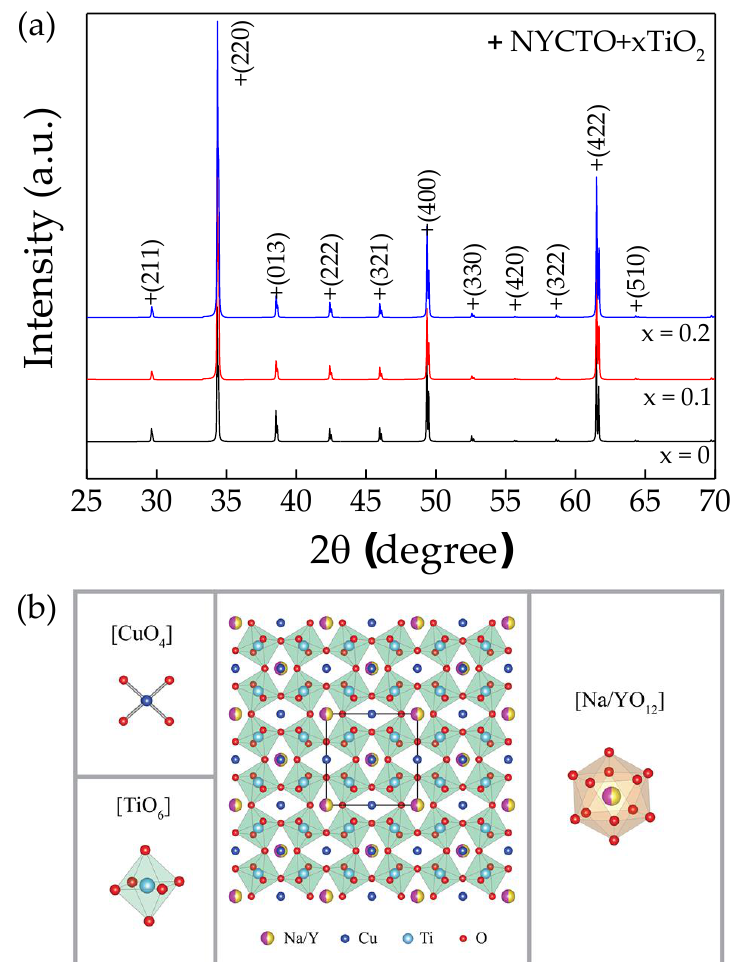
Figure 1. ( a ) XRD patterns of NYCTO + xTiO 2 ceramics with x = 0.0, 0.1 and 0.2. ( b ) NYCTO struc- ture.